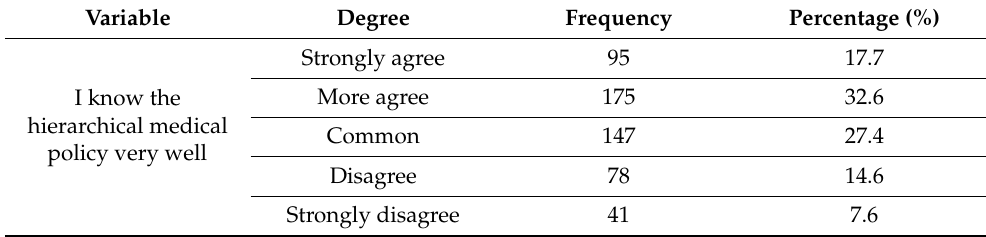
Table 6. Statistics on the understanding of the hierarchical medical policy.